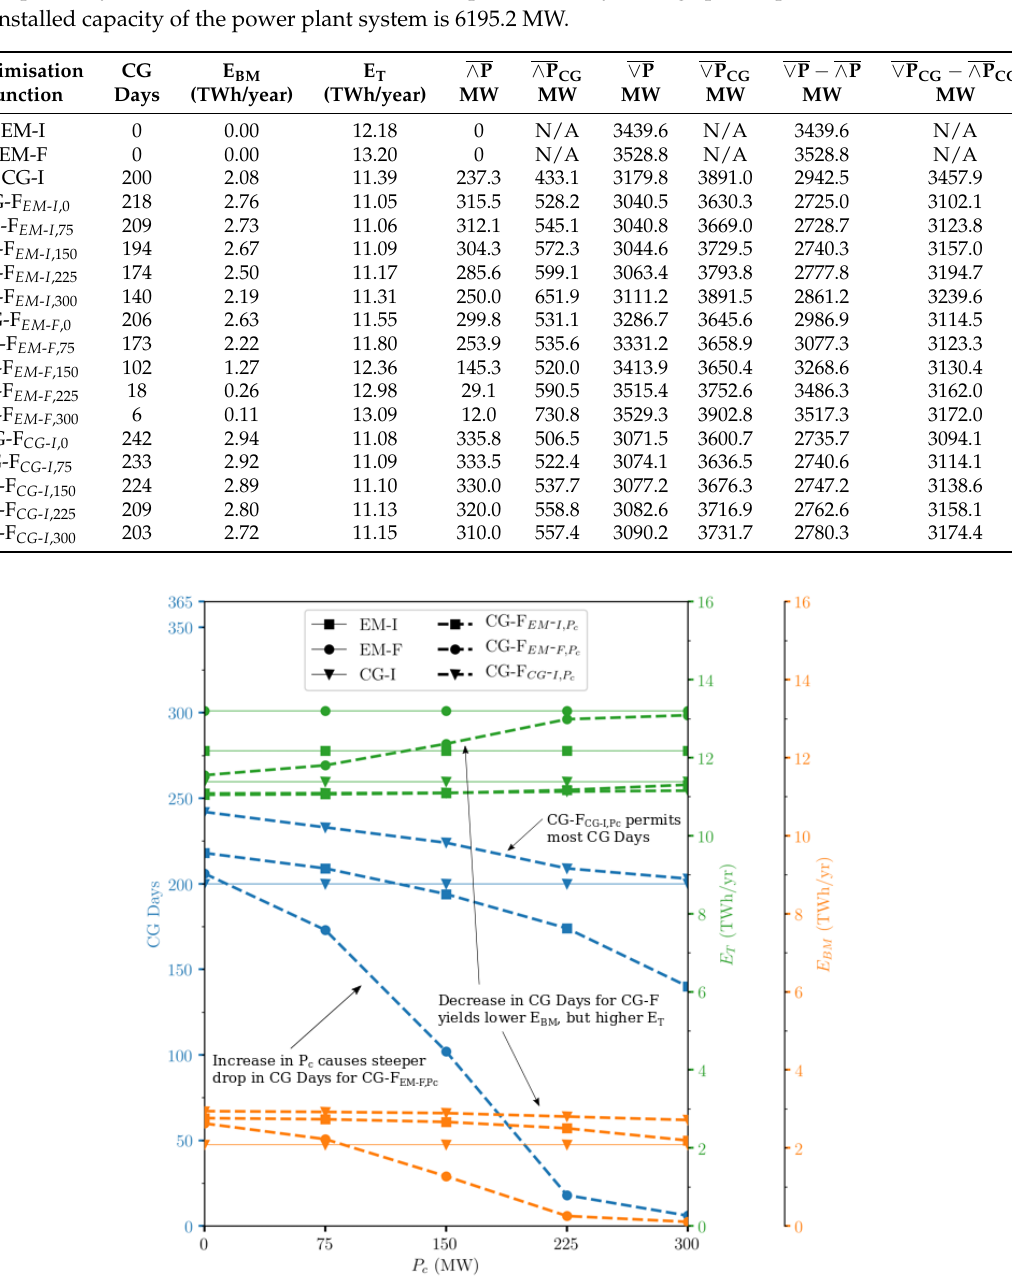
Figure 6. Annual (705 tidal cycles) energy results of optimisation cases from Table 3: total energy output E T (TWh/year), total Baseload Market output E BM (TWh/year) and number of days where ∧ P > 0